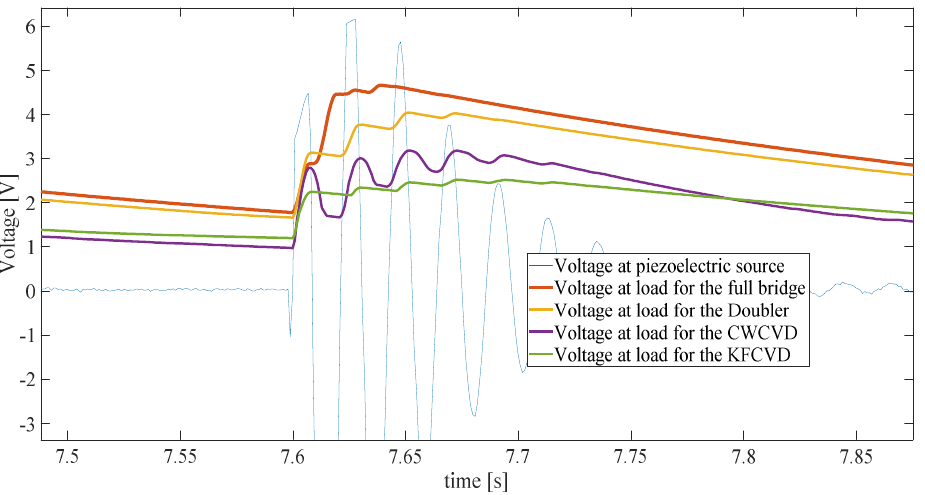
Figure 19. Voltage obtained for internal resistance of 1000 Ω for the eighth drop. Full bridge and Greinacher doubler circuit performances are similar.